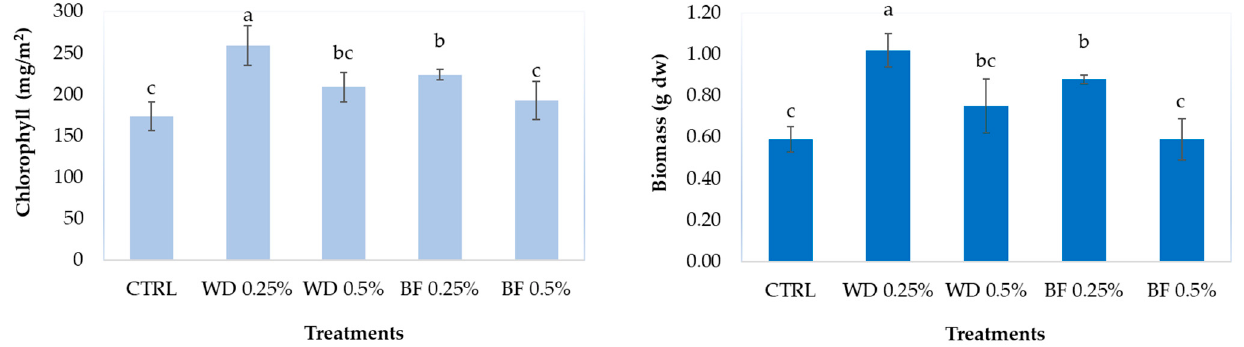
Figure 1. Chlorophyll content and biomass (median ± error) of lettuce leaves after four weekly foliar treatments with water (CTRL), 0.25% and 0.5% WD (BioDea Wood Distillate), and BF (BioDea Flavor). Different letters indicate statistically significant ( p < 0.05) differences between treatments.